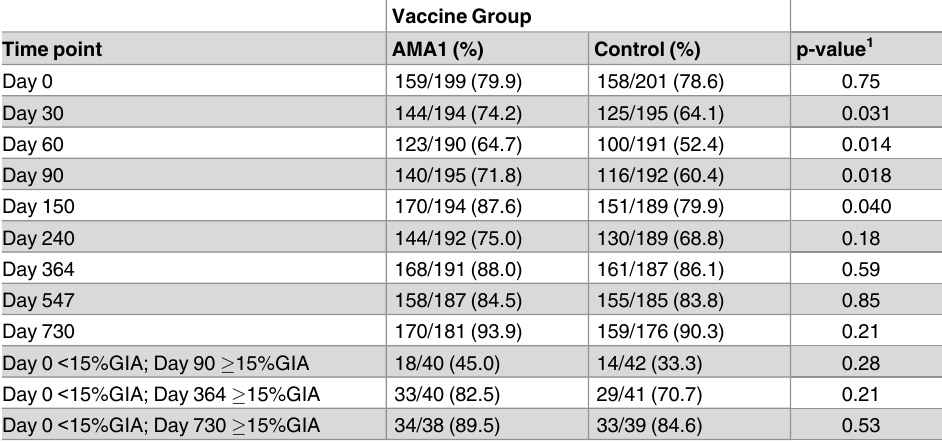
Table 4. Percentage of subjects with growth inhibition assay activity (cid:21) 15% against FVO parasites, and percentage seroconverting from below up to or above threshold 30 days after last vaccination and at one and two yearsafter enrollment, by vaccine